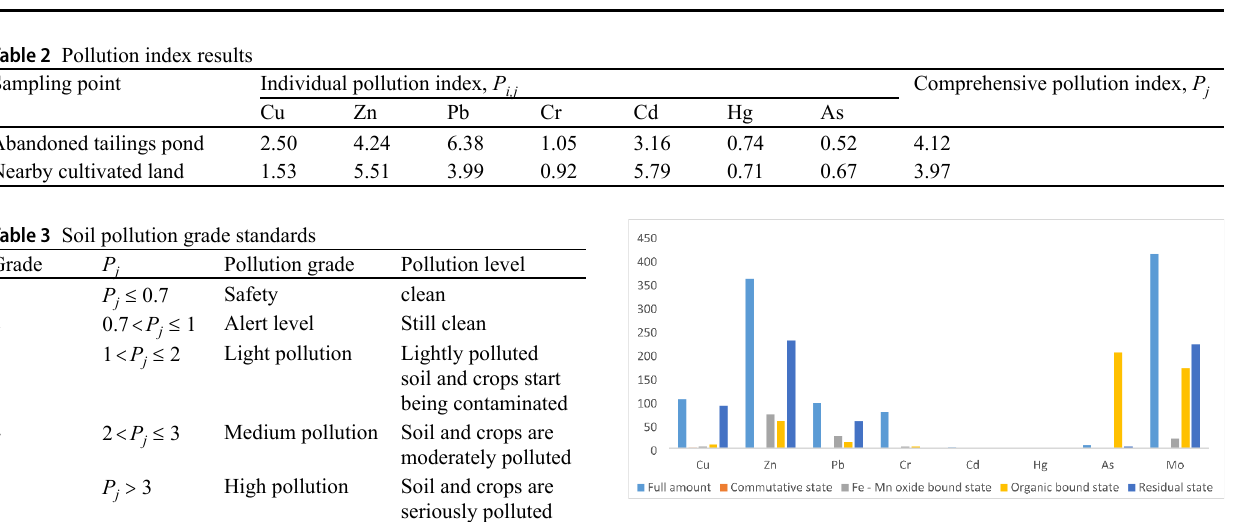
Fig. 2 Content of various forms of heavy metals in the soil of sur- rounding mountain area around the stopes at the study site